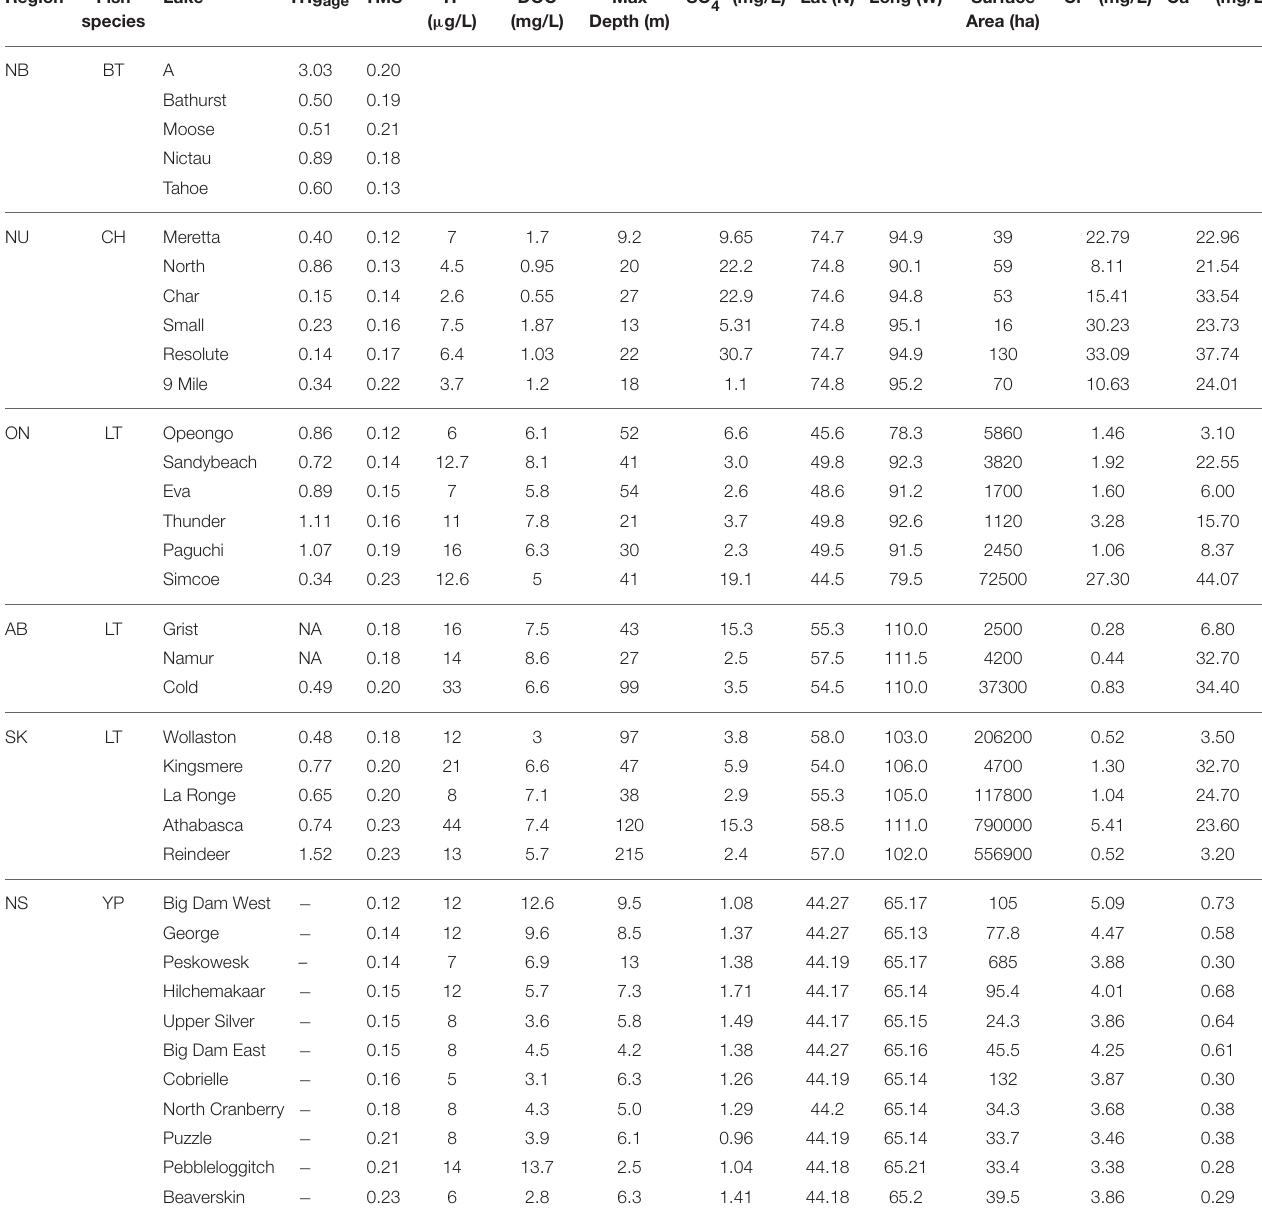
TABLE 5 | Trophic magnification slope (TMS) and select physical and chemical characteristics of Brook Trout (BT; this study; see Table 1 for water chemistry etc. data), Arctic Char (CH), Lake Trout (LT) and Yellow Perch (YP) lakes from New Brunswick (NB), Nunavut (NU), Ontario (ON), Alberta (AB), Saskatchewan (SK), and Nova Scotia (NS) Canada (data from Kidd et al., 2012; Clayden et al., 2013; Lescord et al., 2015).